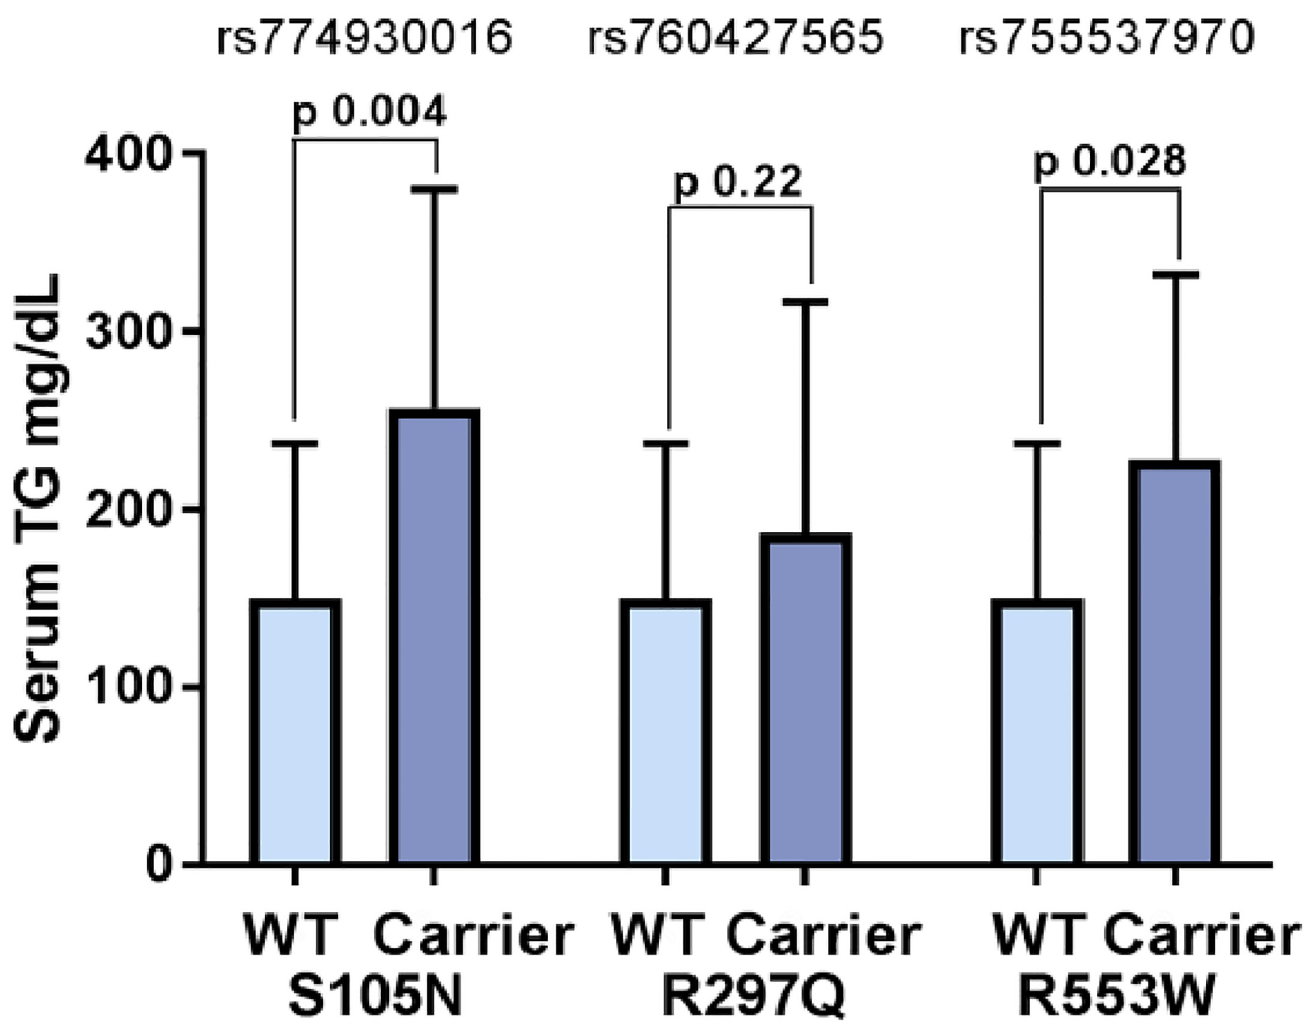
Fig 4. Serum Triglyceride mean distribution among carriers and non-carriers of missense variants. Bar graph shows the differences in the distribution of mean serum triglycerides among carriers and non-carriers of missense mutations (S105N, R297Q, and R553W) represented by rs774930016, rs760427565, rs755537970 variants, respectively. Data are shown in mean and standard deviation of means. P values are derived from the general mixed linear models used to test the impact of genetic variants on transformed continuous trait (TG) using the variance-component test adjusted for the random-effects of relatedness and fixed effects of age, gender, BMI and type 2 diabetes. Only association of S105N would remain significant after applying Bonferroni correction.